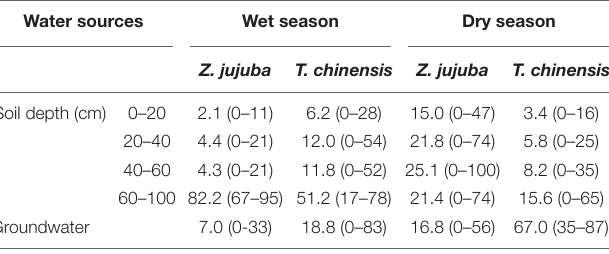
TABLE 2 | Proportions of potential water sources (%) for Tamarix chinensis and Ziziphus jujuba in dry and wet seasons. Water